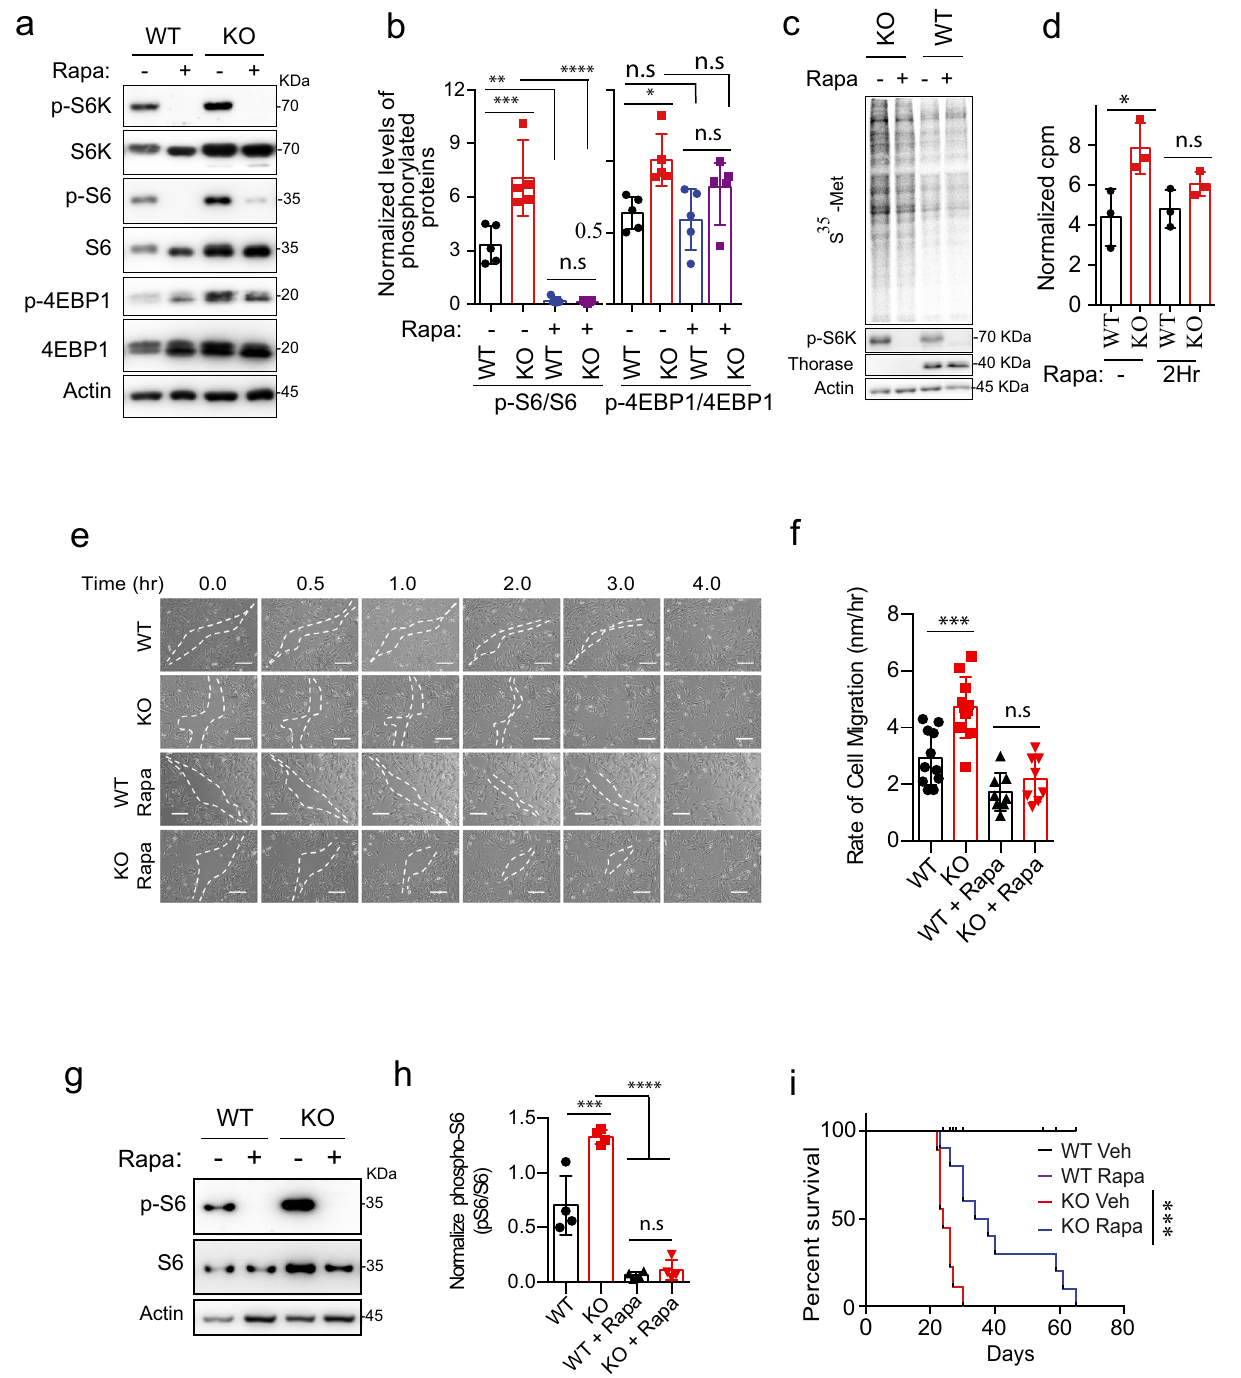
Fig. 7 | Rapamycin ameliorates phenotypes arising from Thorase dependent abnormal mTORC1 activation. a Immunoblot images showing rapamycin (Rapa) treatment normalizes elevated mTORC1 activity in Thorase KO cells. b Quanti fi cation of blots in a ( n =5 independent experiments). c Representative images showing rapamycin (Rapa) inhibits increased protein synthesis in Thorase KO cells. d Quanti fi cation of blots in c ( n =3 independent experiments). e Representative MEF migration images showing Rapa treatment normalizes increased cell growth and migration in Thorase KO MEFs. Broken white lines show areas without cells (scratched areas). Scale bars are 100 μ m. f Quanti fi cation of images in e ( n =11 control and 8 rapamycin treatments). g Immunoblot images